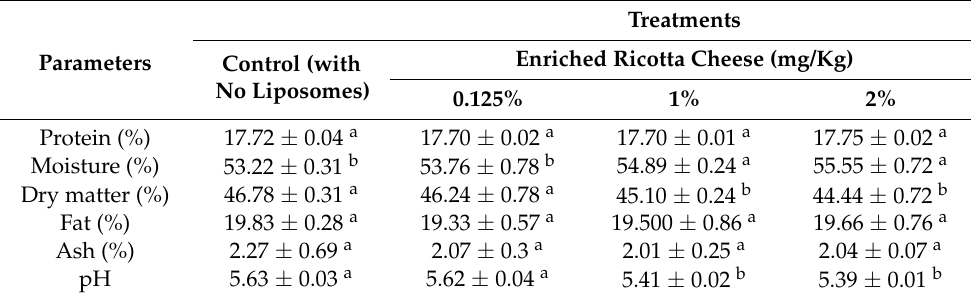
Table 3. The chemical composition and pH of ricotta cheese enriched with various concentrations of liposomal saffron extract.